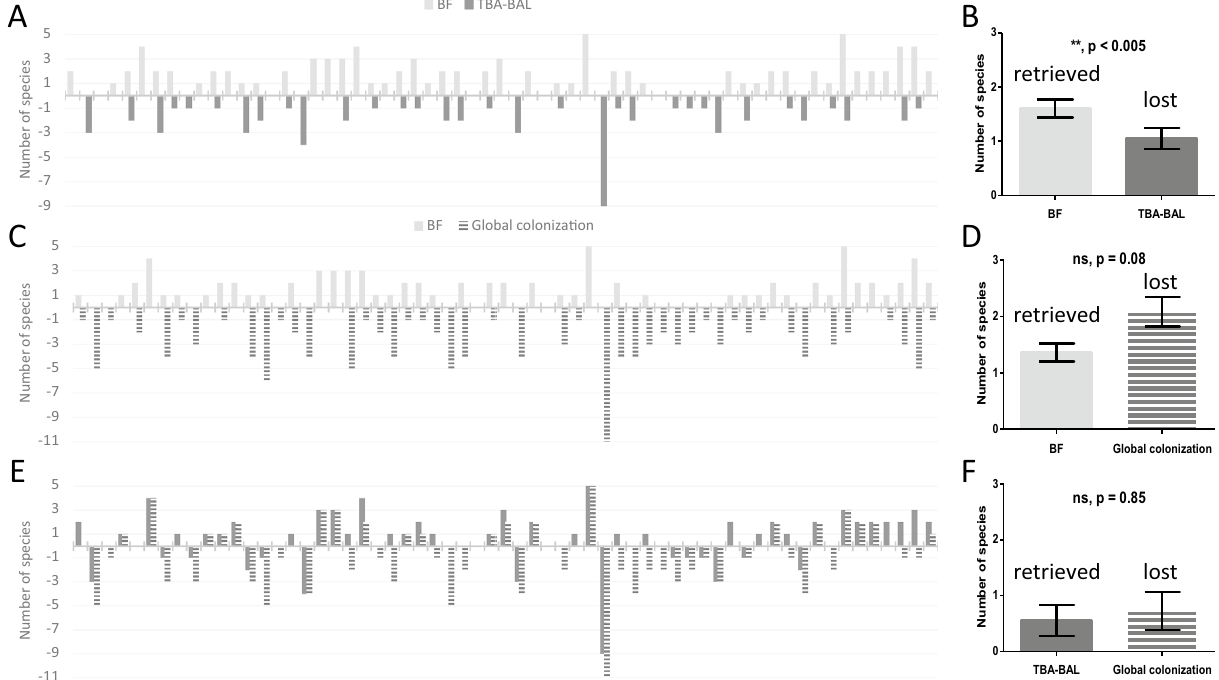
Figure 5. Microbiological species either retrieved or lost from BF analysis in comparison to respiratory samples (TBA-BAL) or global colonization (TBA-BAL, CVC-AC, urinalysis and other colonization/infection sites). ( A ) number of microbiological species either retrieved or lost from BF analysis in comparison to respiratory samples for each patient ; ( B ) absolute value of the median number of microbiological species either retrieved or lost from BF analysis in comparison to respiratory samples, all patients combined ; ( C ) number of microbiological species either retrieved or lost from BF analysis in comparison to global colonization for each patient ; ( D ) absolute value of the median number of microbiological species either retrieved or lost from BF analysis in comparison to global colonization, all patients combined ; ( E ) lost and found differential for BF microbiological species in comparison to respiratory samples or global colonization for each patient ; ( F ) absolute value of the median lost and found differential for BF microbiological species in comparison to respiratory samples or global colonization, all patients combined. AC arterial catheter, BAL bronchoalveolar lavage, BF biofilm, CVC central veinous catheter, TBA tracheobronchial